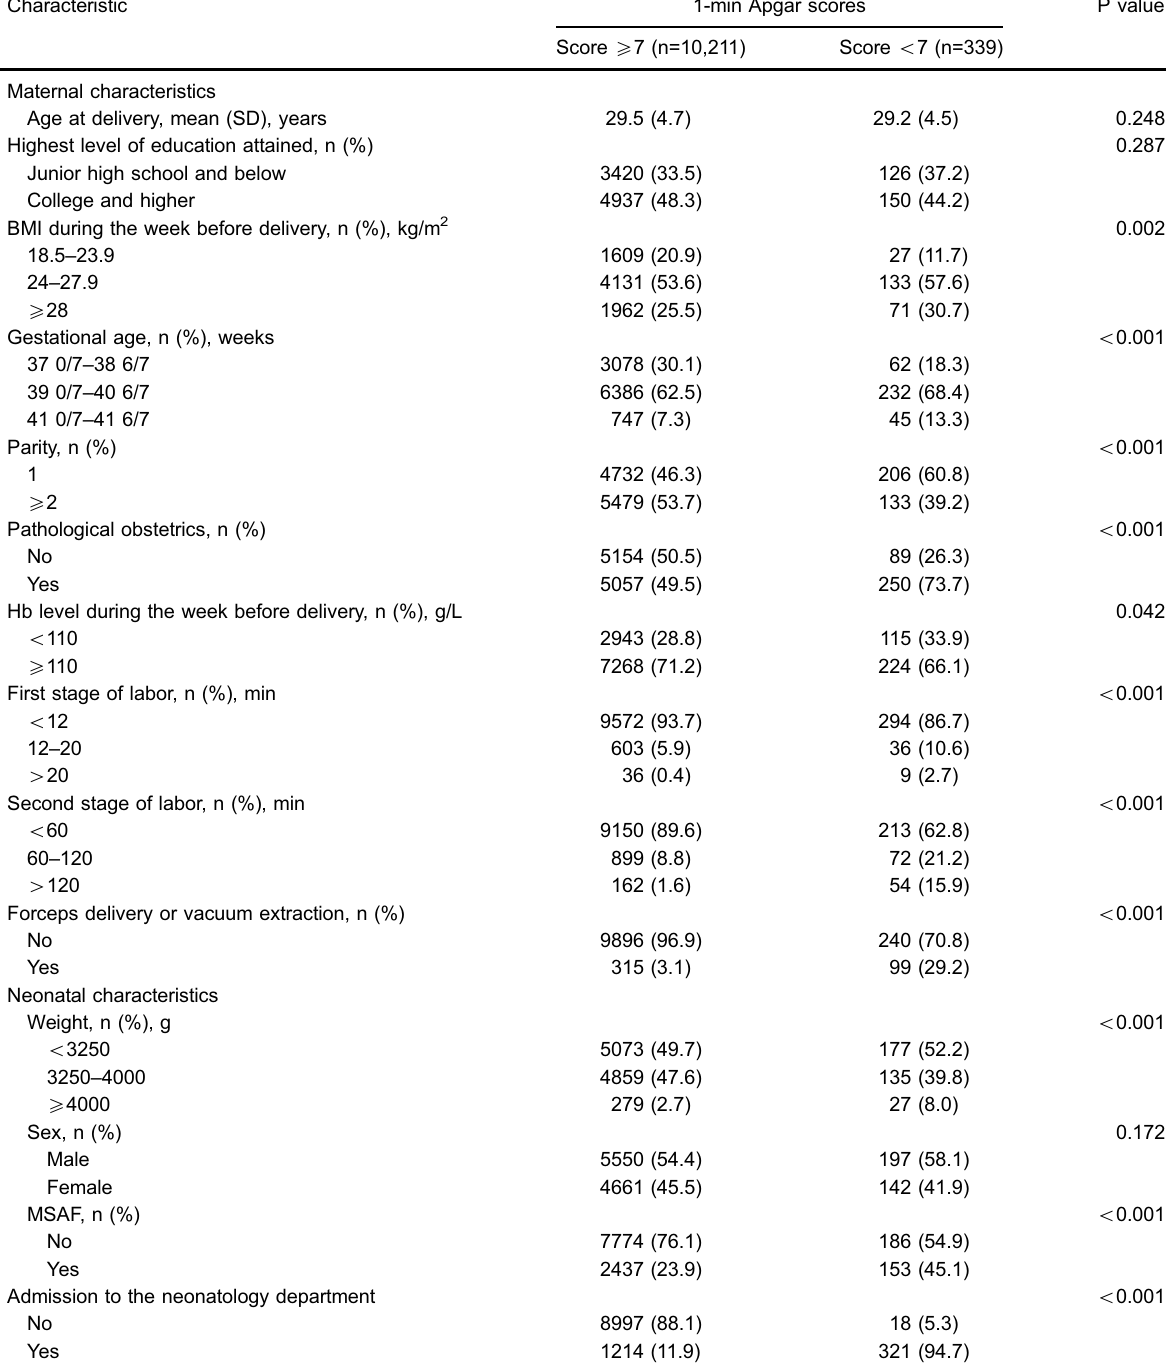
Table 2. Comparison of maternal and neonatal clinical characteristics in infants with normal 1-min Apgar scores ( X 7) vs low 1-min Apgar scores ( o